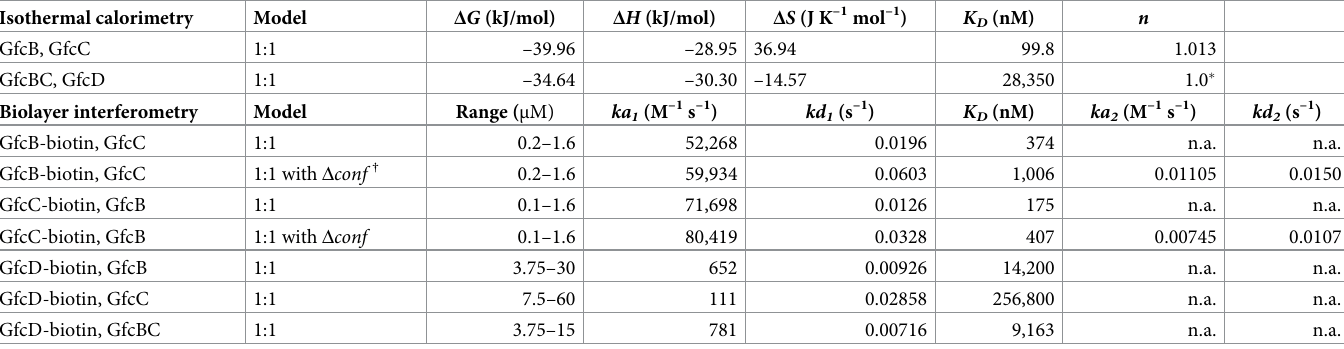
Table 2. Affinities of interactions of GfcB, GfcC, and GfcD. Isothermal